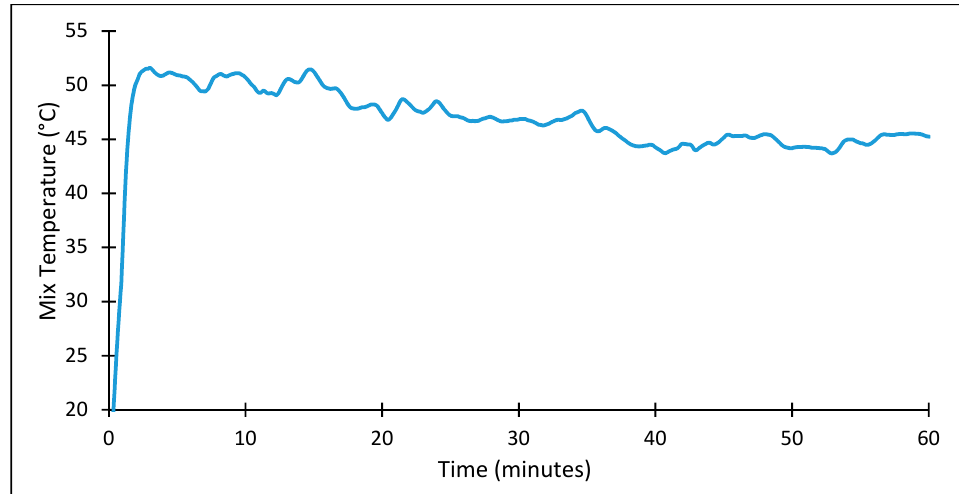
Figure 23. Temperature of fresh geopolymer paste using Method VII.